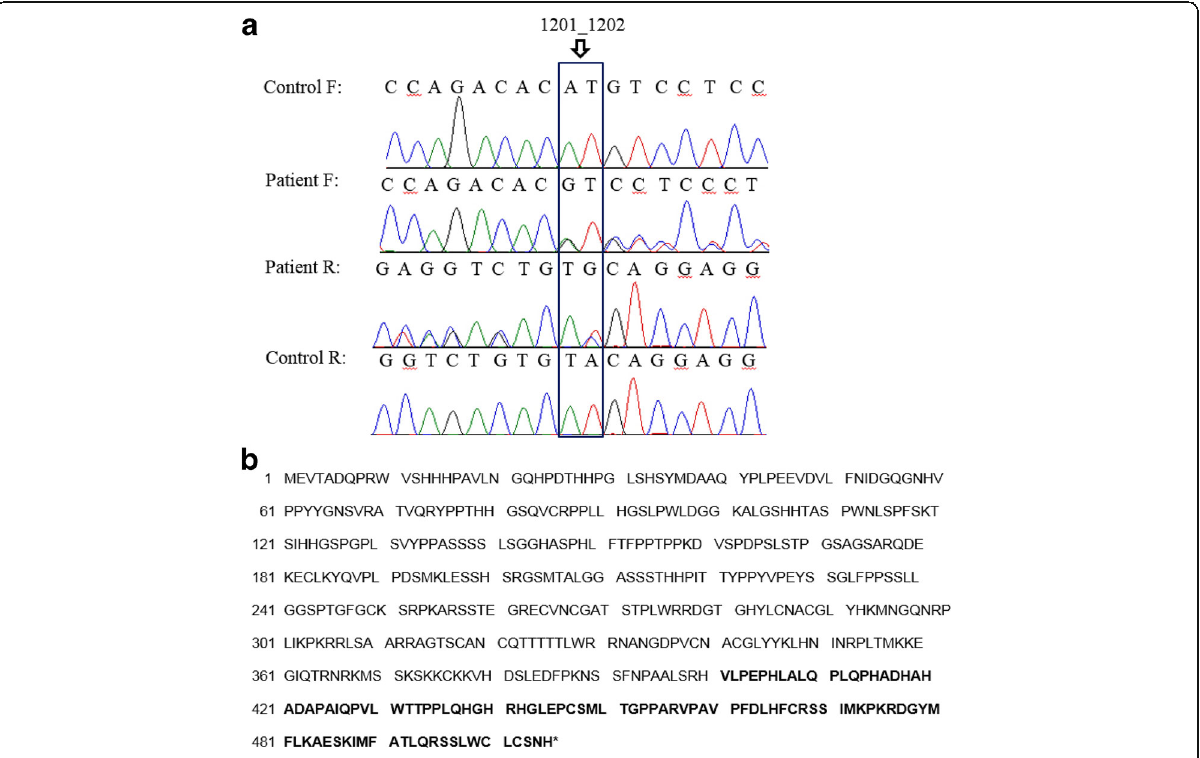
Fig. 2 a Electropherogram of part of GATA3 exon 6. Our case had a heterozygous 1201_1202del AT of the GATA3 gene. Sequences of the control and the patient alleles are reported. A control reveals any carriers with the c. 1201_1202del AT. F and R indicate forward and reverse sequencings, respectively. b Wild-type sequence and predicted amino acid sequence resulting from frameshift mutation. Bold type indicates the new amino acid